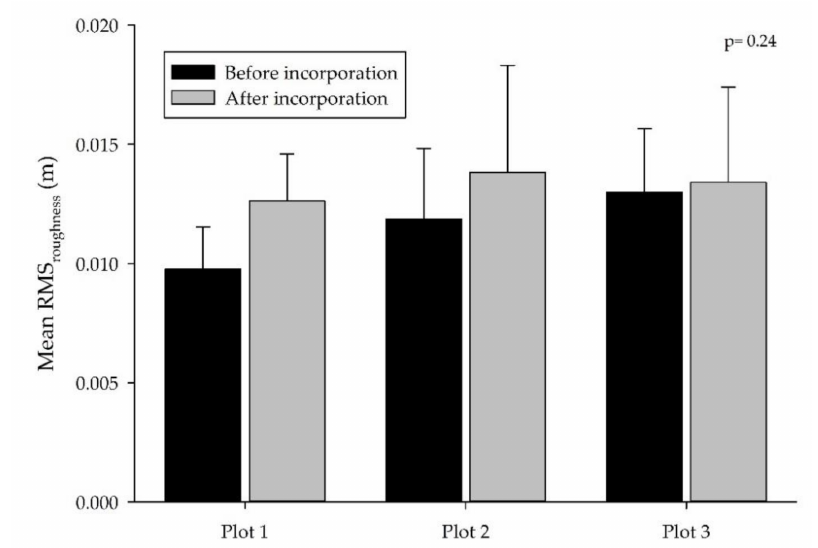
Figure 8. Arithmetic mean RMS roughness (m) of the measured profile before and after the incorpora- tion of the nonwoven. The measurement was performed by ultrasonic sensor. The error bar shows the standard deviation. n = 14. The p -value shows the paired Tukey test for mean RMS roughness before and after the incorporation calculated for all three